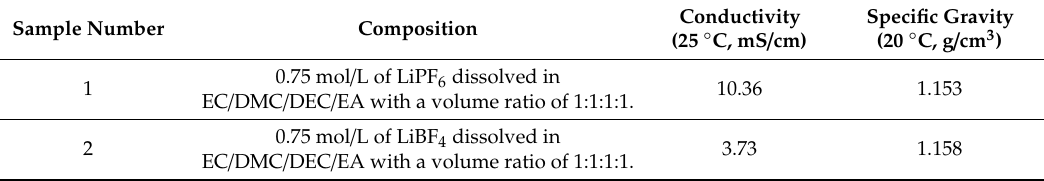
Table 2. Composition and parameters of the two kinds of electrolyte in this